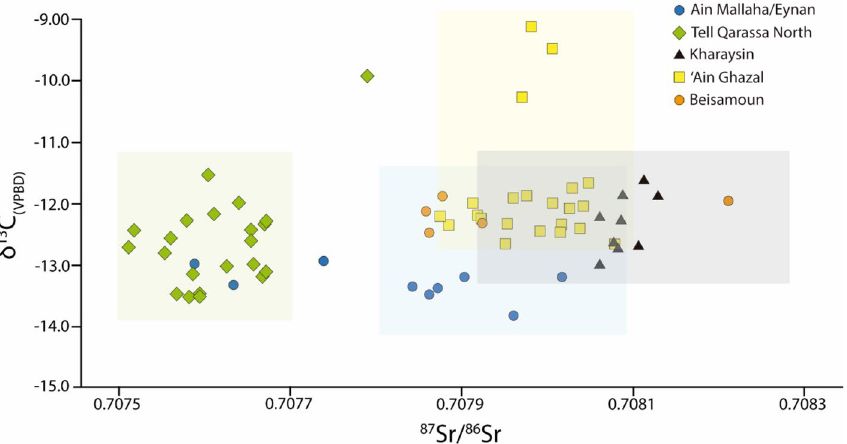
Figure 4. Scatter plot of the δ 13 C and 87 Sr/ 86 Sr isotope ratios of the 67 individuals from the five archaeological sites of the Southern Levant. Isotope ratios for individual sites are plotted in Fig. S4 (Supplementary Information). The light colour figures mark the Sr local baseline range at each site: blue (‘Ain Mallaha/Eynan and Beisamoun, 0.70782–0.70808); green (Tell Qarassa North, 0.70750–0.70770), yellow (Kharaysin, 0.70792 to 0.70828), and black (‘Ain Ghazal,